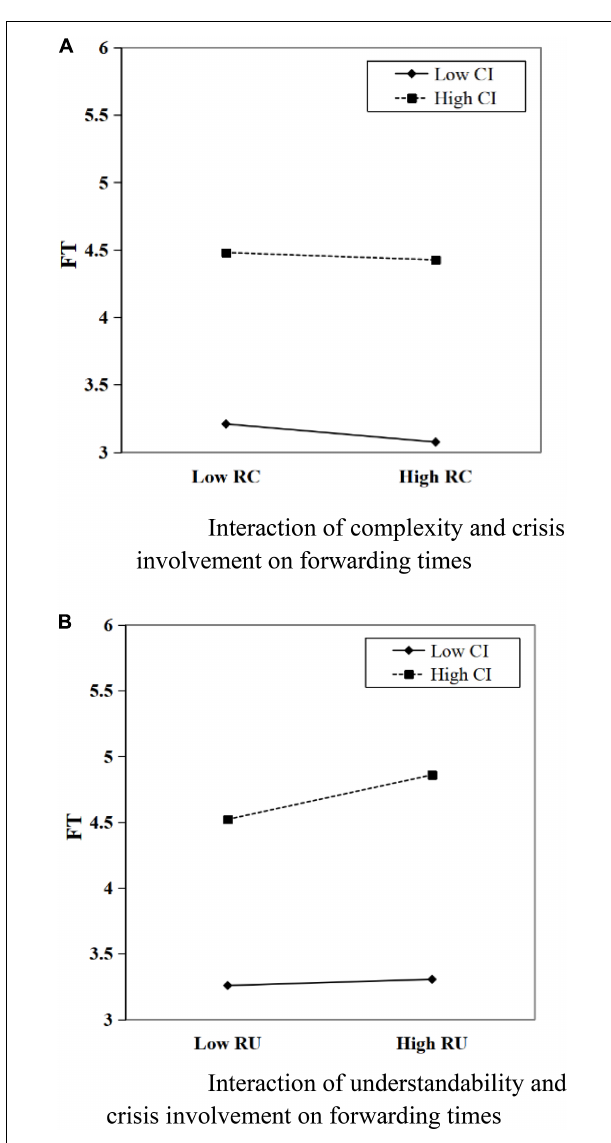
FIGURE 4 | (A) Interaction of complexity and crisis involvement on forwarding times. (B) Interaction of understandability and crisis involvement on forwarding times.